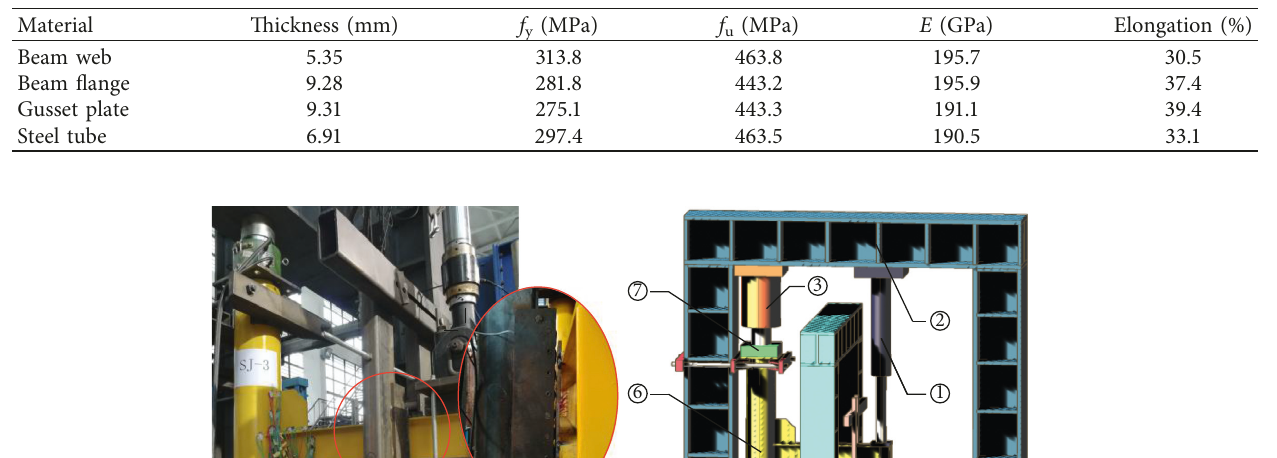
Table 2: Material properties of steel.